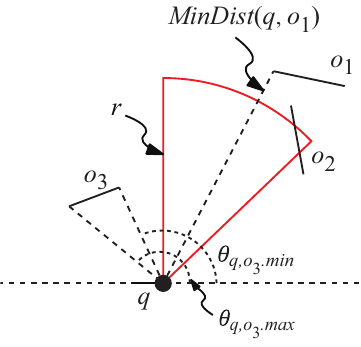
Figure 9. o 2 is inside the view field, but o 1 and o 3 are